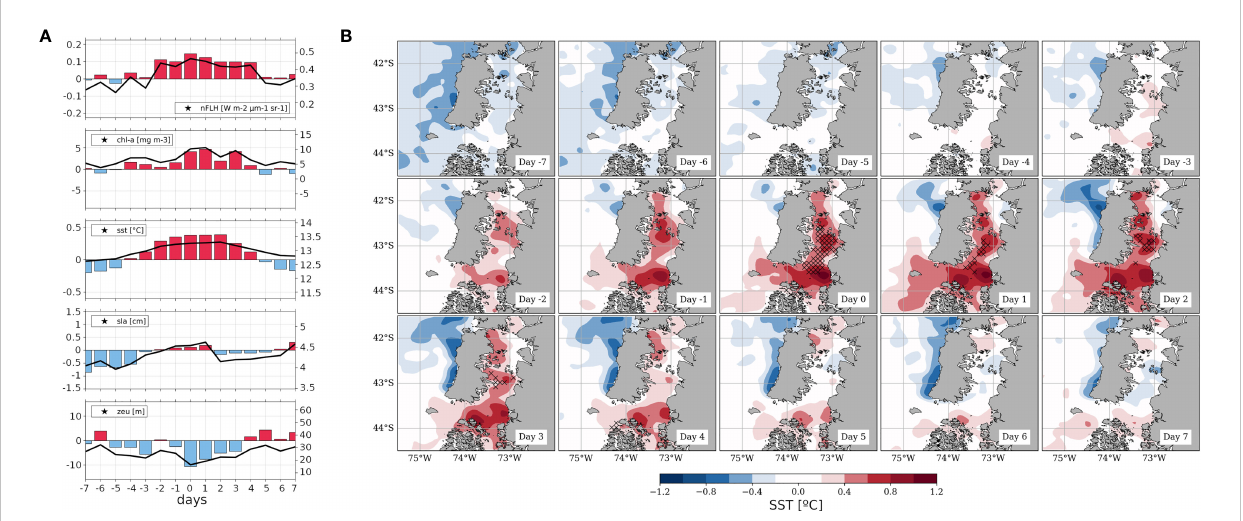
FIGURE 5 (A) Composite time series averaged from the 16 HBE within the S-ISC subregion (42.5°-43.5° S; see Figure 1A) for a sequence centred on the HBE onset, i.e., on day 0, spanning from day -7 to day +7. Variables correspond to nFLH [W m -2 µm -1 sr -1 ], CHLA ’ [mg m -3 ], SST ’ [°C], SLA [cm] and ZEU [m]. The right-hand y-axis of each panel shows the absolute values on solid black lines centred around the mean DJF value (central horizontal line), while the left y-axis shows the positive (negative) SY-IS anomalies on red (blue) bars centred around 0. (B) As Figure 4B, but showing SST ’ ( fi lled contours, see colour scale), ZEU (for graphical convenience with respect to the SST ’ pattern, crosses (dots) depict shoaling (deepening) anomalies below -14m (above